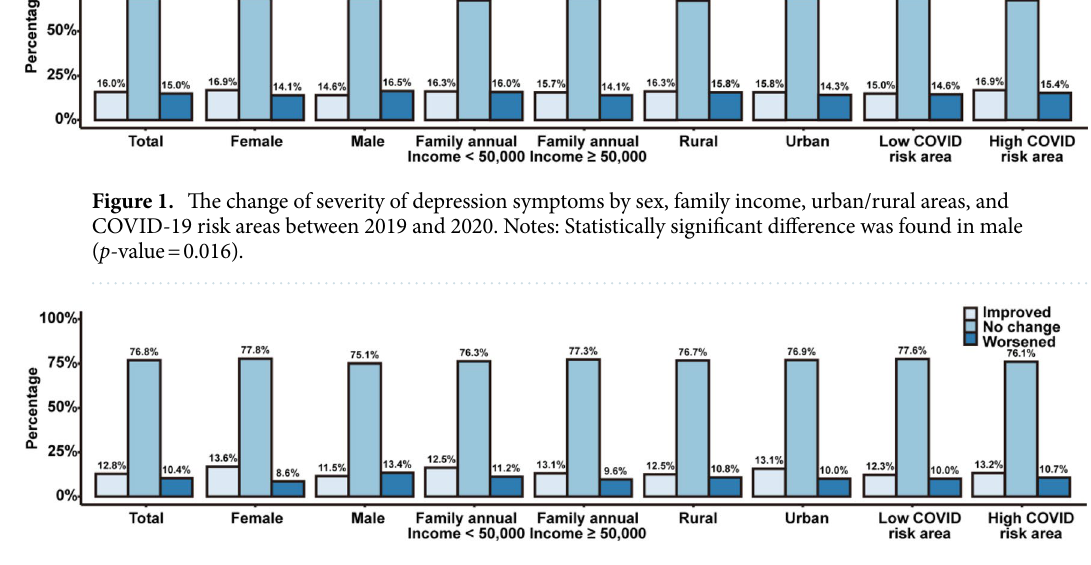
Figure 2. The change of severity of anxiety symptoms by sex, family income, urban/rural areas, and COVID-19 risk areas between 2019 and 2020. Notes: Statistically significant difference was found in total ( p -value = 0.007), females ( p -value < 0.001), individuals from annual income ≥ 50,000 families ( p -value < 0.001), individuals from urban areas ( p -value = 0.006), and individuals from high COVID-19 risk areas ( p -value = 0.042).